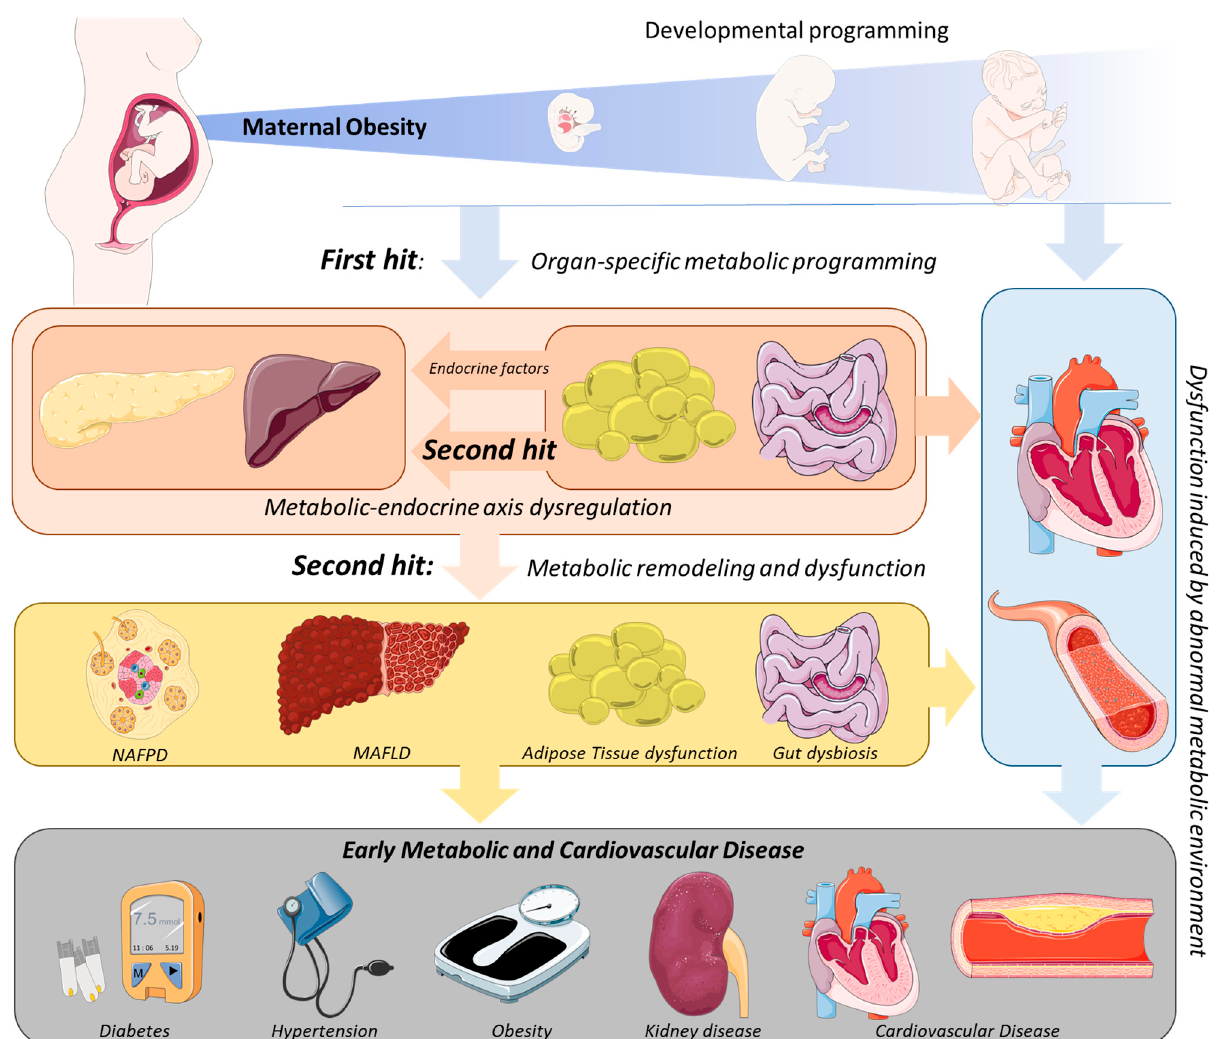
Figure 1. Mechanism of endocrine-metabolic axis programming in offspring due to maternal obesity. Throughout fetal development, Maternal Obesity (MO) programs organ-specific dysfunction through the modulation of cell proliferation, growth rates, differentiation, and maturation—the first hit of developmental programming. Consequently, metabolic dysregulation is commonly observed in organs in early life stages, which leads to different metabolic homeostasis in MO offspring. Among these, the adipose tissue and gut are organs with an important endocrine role in the endocrine–metabolic axis. Adipose tissue dysfunction and gut dysbiosis are early organ-specific events in MO offspring, promoting the release of endocrine proteins (e.g., adipokines, glucagon-like pep-